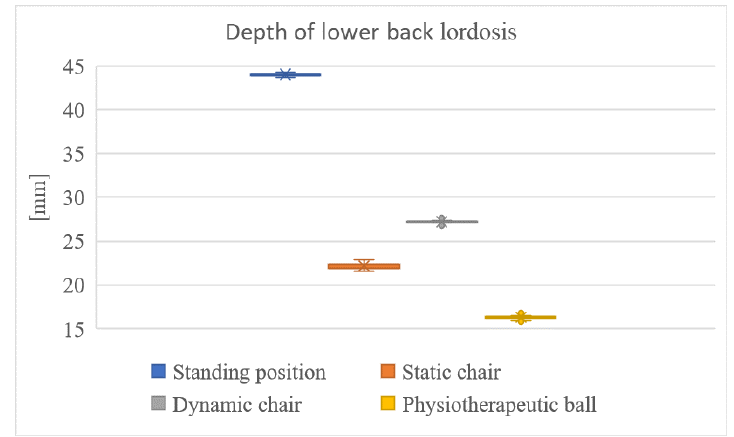
Figure 11. Range of values of the followed body parameters.